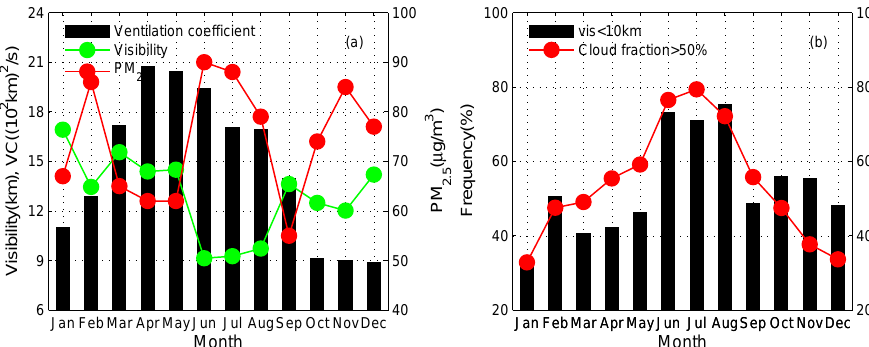
Figure 12. Monthly variations in visibility, PM 2 . 5 , and ventilation coefficients (a) and frequency of visibility < 10km, and cloud fraction > 50% (b) in